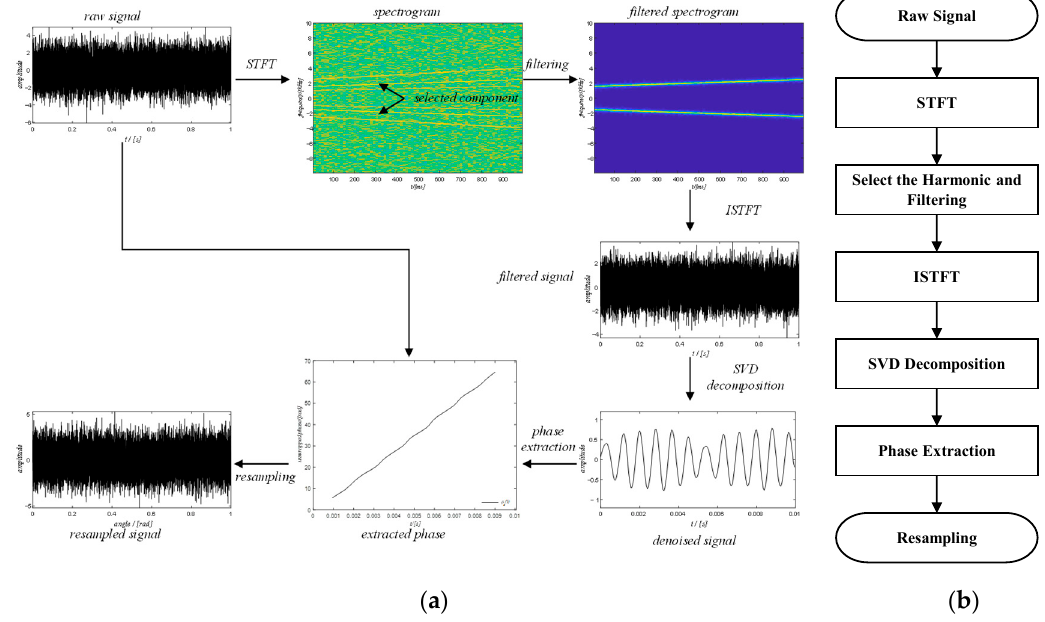
Figure 11. ( a) The schematic diagram of the new method; ( b ) the flowchart of the new method. Figure 11. ( a ) The schematic diagram of the new method; ( b ) the flowchart of the new